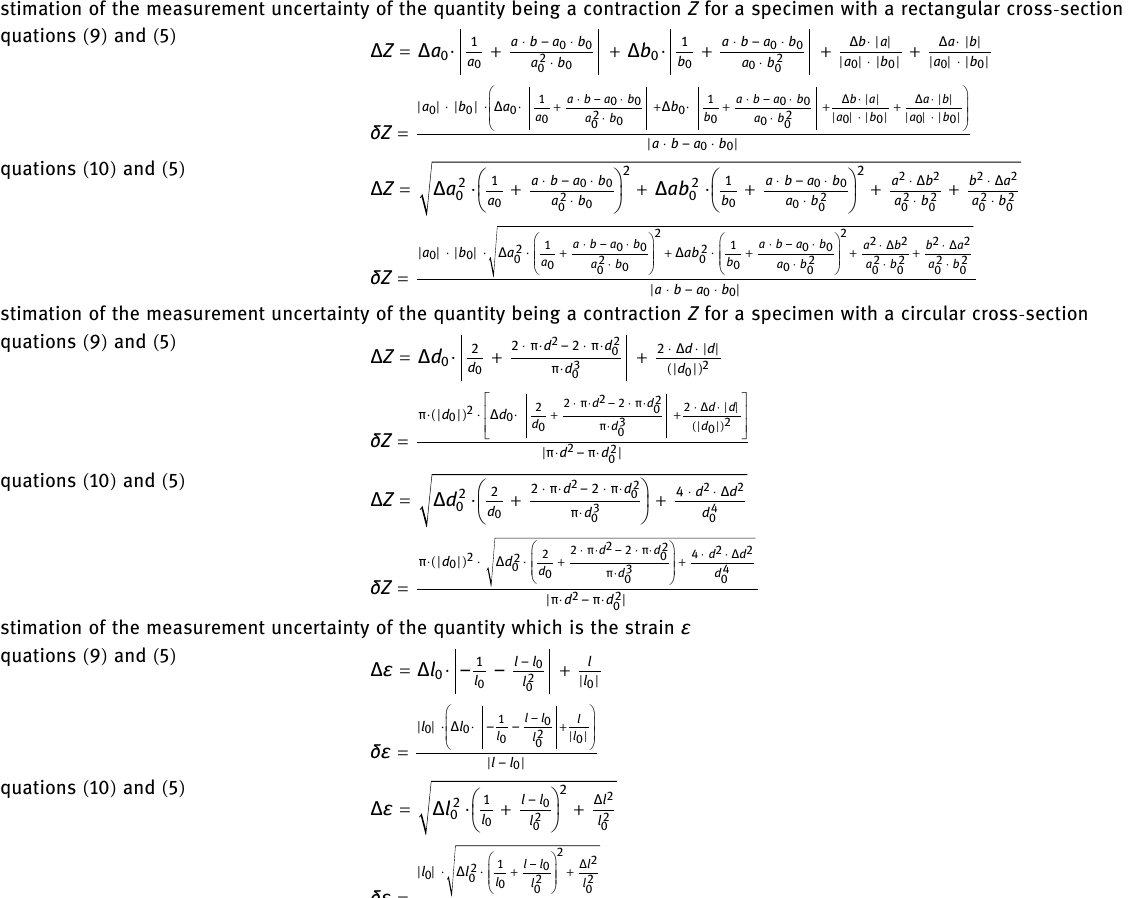
Equations ( 10 ) and ( 5 )